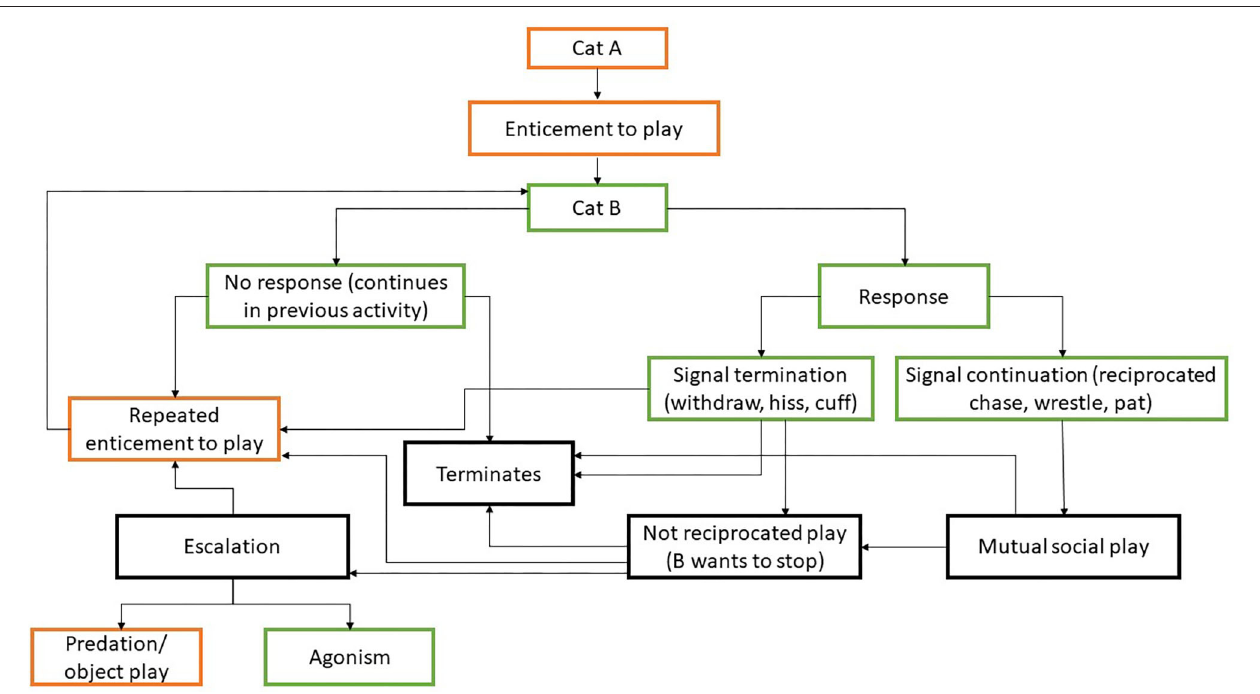
FIGURE 2 | The elements intricately linked with intercat play (including elements of mutual intercat play). Any element could be considered part of play, due to context but motivationally may involve other systems [inspired by diagram of the sequence of interactions in black bear social play